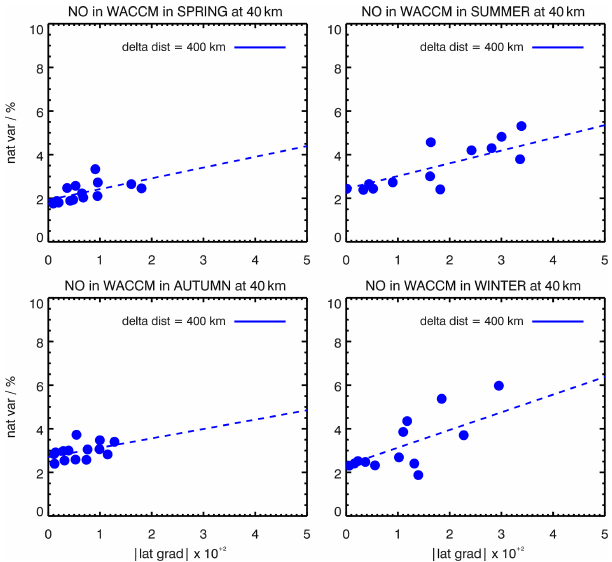
Figure 7. Natural variability of NO as a function of latitudinal gra- dients for a 400km distance separation at 40km altitude in four seasons in the WACCM